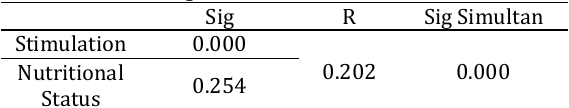
Table 1. Ordinal Regression